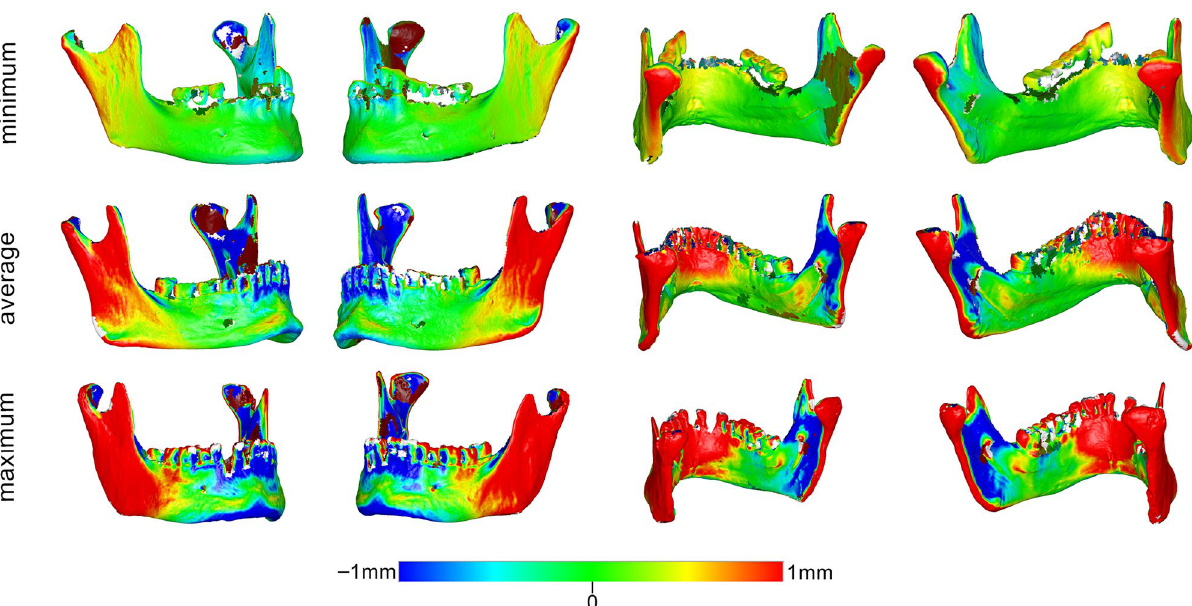
Figure 5. Color coded distance maps of mandibles showing the difference between dry (reference) and wet models, depicted through models that corresponded to the minimum, average and maximum error detected in the pre-specified measurement areas. Zero distance between best-fit approximated repeated scans indicates perfect